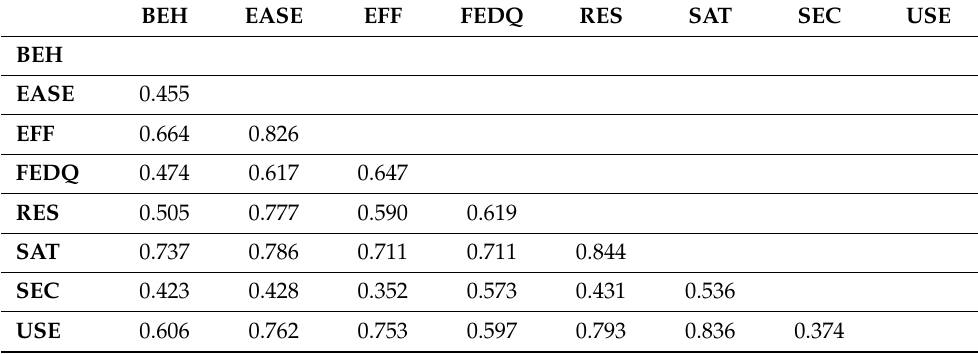
Table 4. Heterotrait–Monotrait ratio of correlations (HTMT).